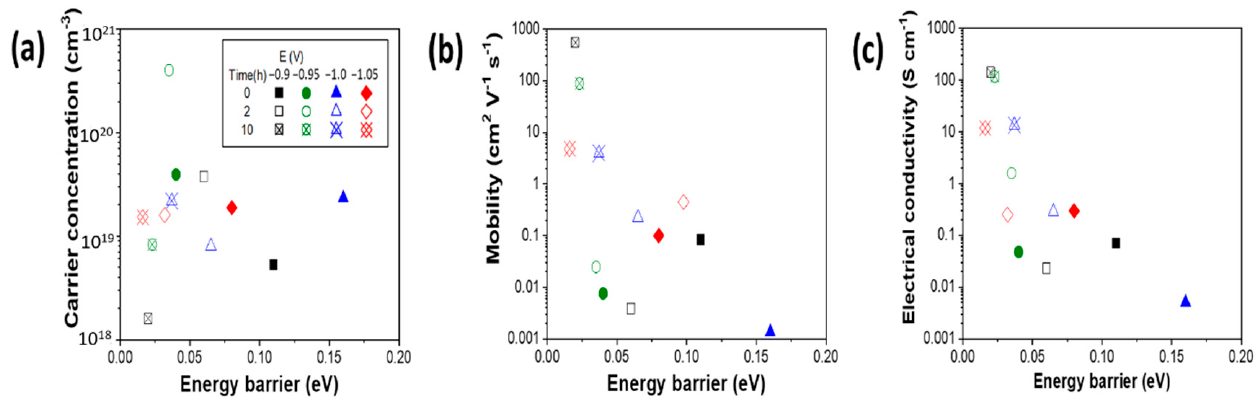
Figure 4. Change of energy barrier (EB) of as-deposited and annealed PbTe films at 200 °C for 2 and 10 h as a function of grain size of PbTe phase ( a ) and Te phase ( b ).